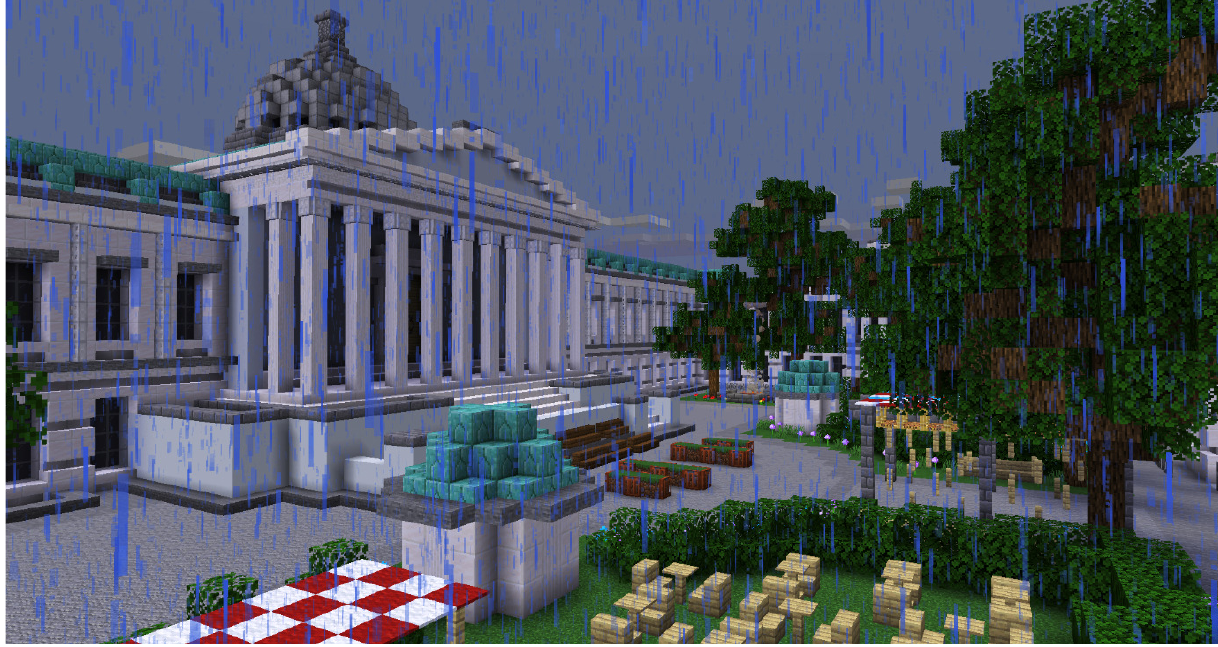
Figure 6. Minecraft plot by PixelatedSun: UCL Quad in the